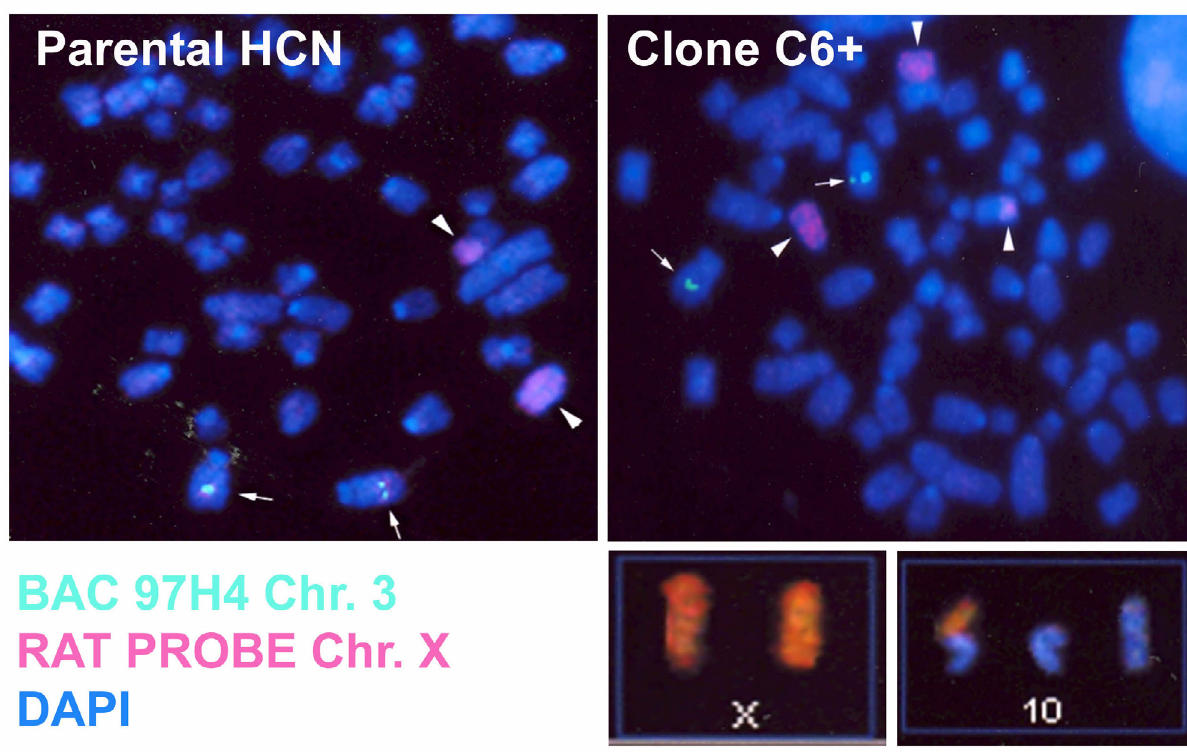
Figure 4 - Inverse PCR putative interchromosomal translocation confirmation in Clone C6+ cells. Isolated cellular chromosomal spread in metaphase hybridized with X paint probe (arrowheads) and a BAC probe control for chromosome 3 (arrows) illustrates the extra fluorescence signal observed in the Clone C6+ but absence in the HCN parental cell. Bottom: spectral analysis of chromosomal spreads in the Clone C6+ revealed a translocation between chromosome X (brown) and chromosome 10